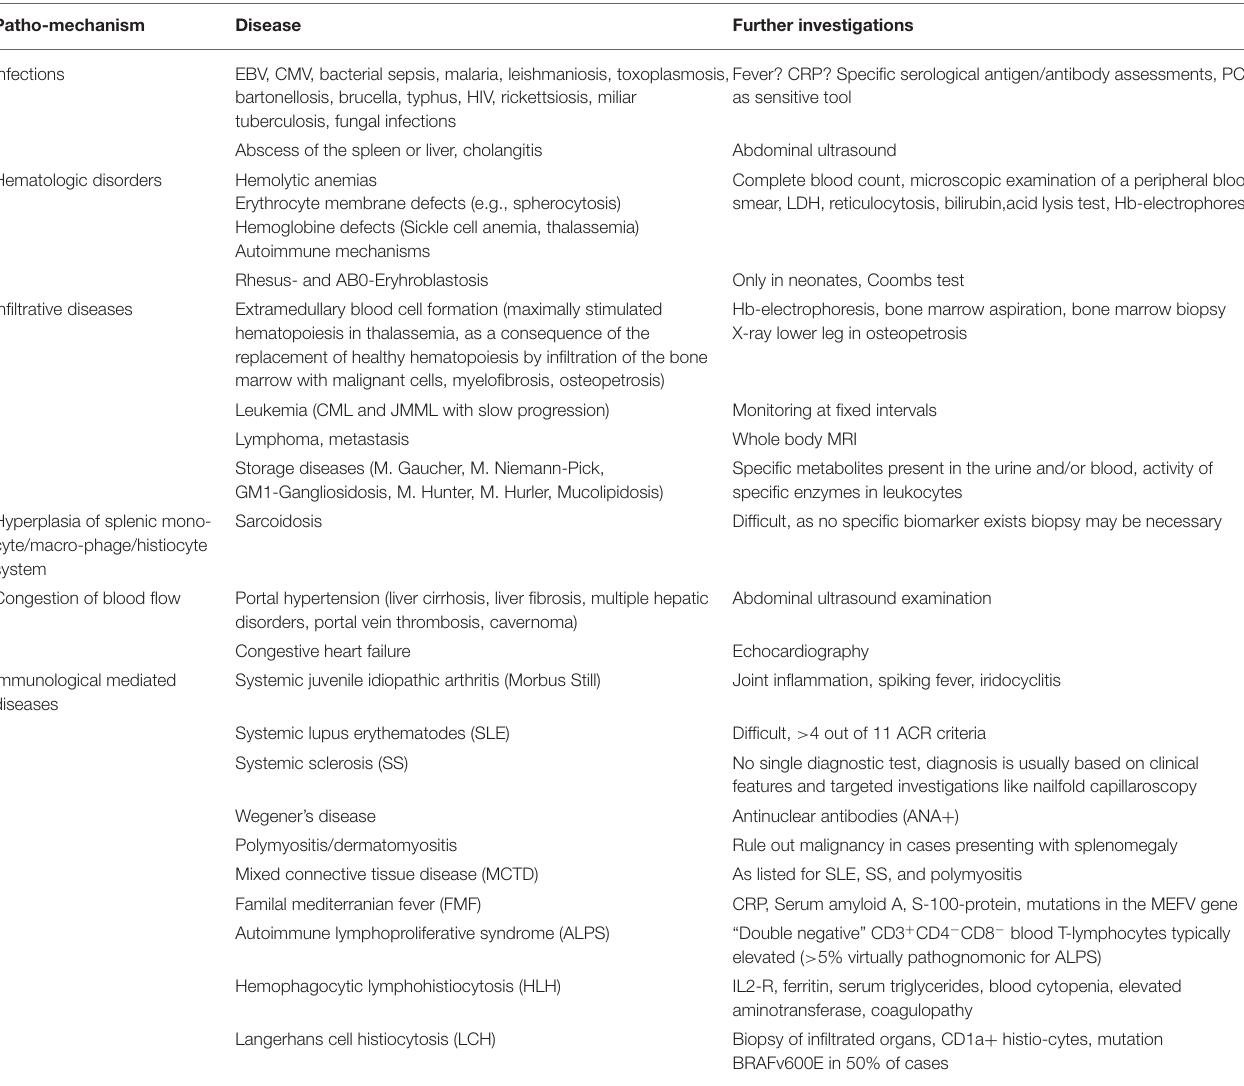
TABLE 3 | Pathogenic mechanisms promoting splenomegaly in defined diseases and helpful further investigations to ascertain the diagnosis.